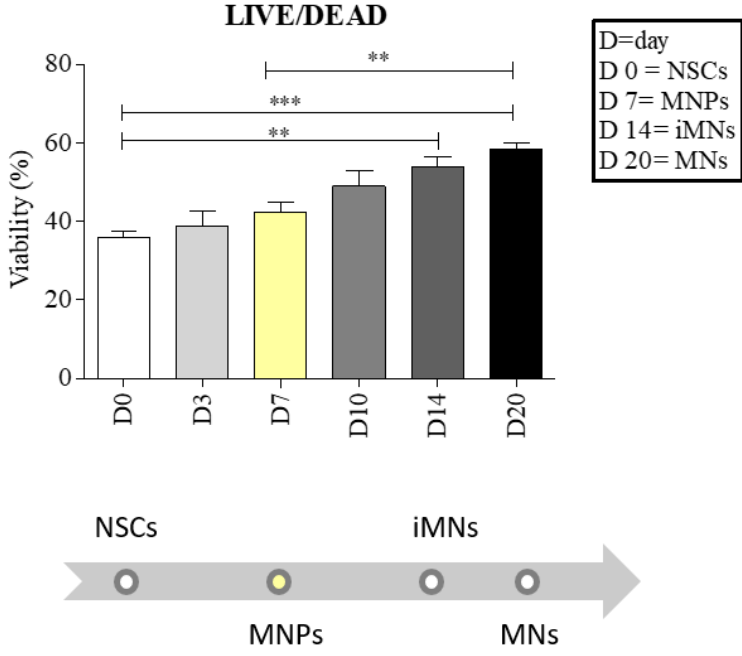
Figure 1. Neural stem cells (NSCs) maintain good viability during the differentiation to motor neurons (MNs). The cell viability was evaluated at days 0, 3, 7, 10, 14 and 20 of differentiation. At day 7, the cells reached the stage of motor neuron progenitors (MNPs), and the viability was increased by 18%. The MNPs bar is in yellow because it is the first stage of cell specialization to MNs. At day 14, MNPs reached the stage of immature motor neurons (iMNs) with an increase in viability of 50%, whereas at day 20, MNPs reached the stage of MNs with an increase in viability of 62%. There is a statistically significant difference between NSCs and iMNs (** p < 0.01), between NSCs and MNs (*** p < 0.001) and between MNPs and MNs (** p < 0.01). Error bars indicate SD. Data were analyzed using ANOVA, followed by the Bonferroni test (GraphPad Prism